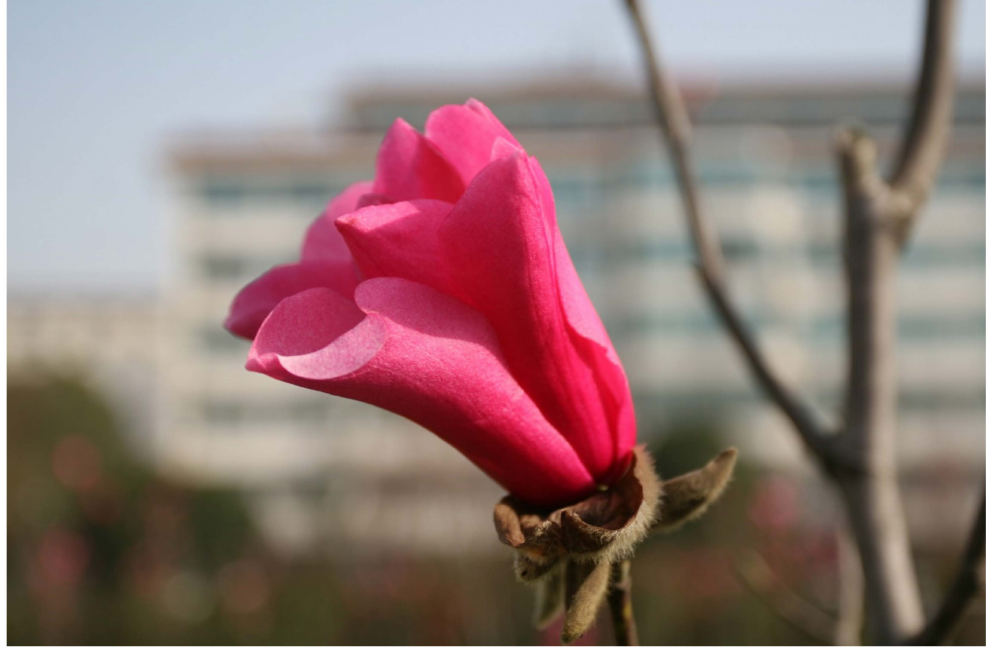
Figure 1. A Magnolia wufengensis flower in Wufeng County, Hubei Province, P.R.